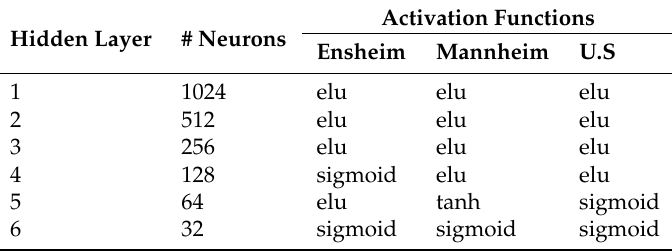
Table 6. Model summary of neural networks.